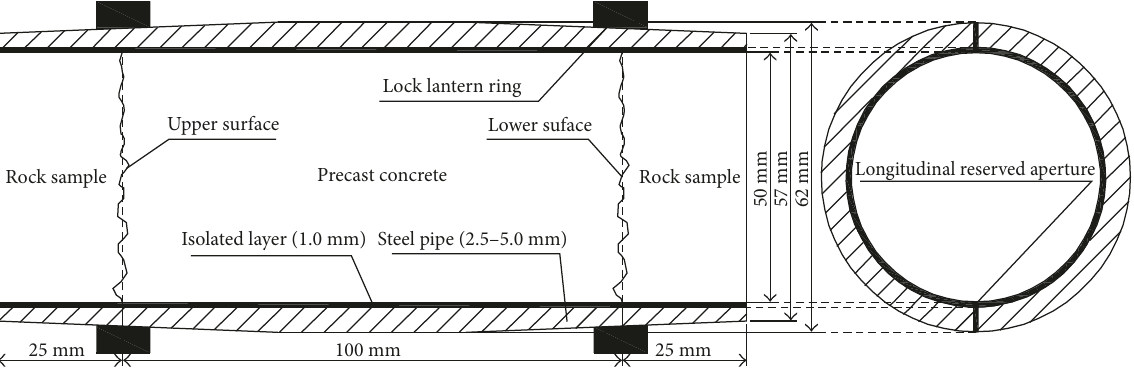
Figure 3: Structure of the mould for the natural rough rock joint surface